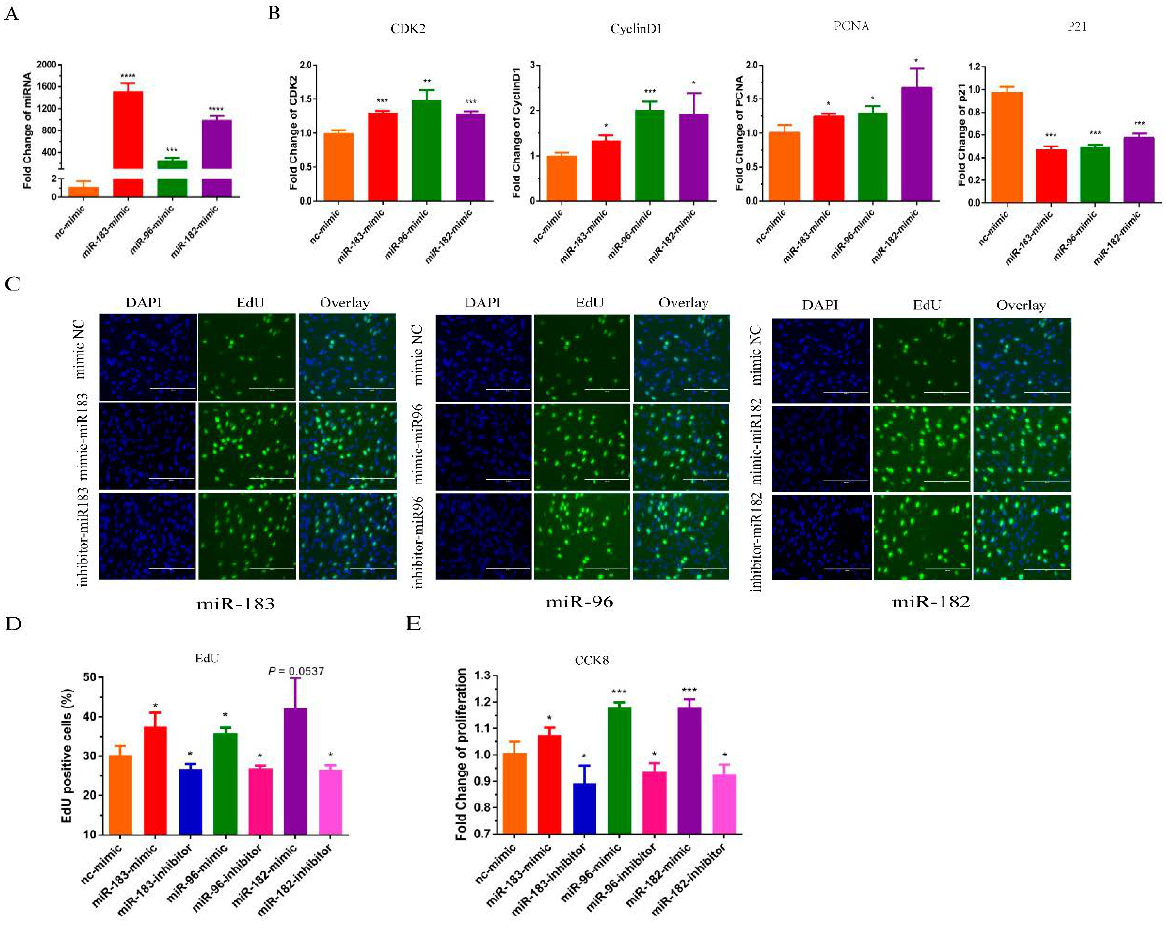
Figure 2. The miR-183/96/182 cluster promotes bovine myoblast proliferation. ( A ) The detection of expression efficiency after the transfection of miR-183/96/182 cluster mimics. ( B ) The expression levels of the cell proliferation genes CyclinD1 , PCNA, CDK2 and P21 mRNA were detected by RT-qPCR. ( C , D ) EdU-positive cells were detected after transfection of the miR-183/96/182 cluster mimics and inhibitors. ( E ) Proliferation in bovine myoblasts was performed by the CCK-8 assay. Data are presented as the means ± SEM. * p < 0.05, ** p < 0.01, *** p < 0.001 and **** p < 0.0001.